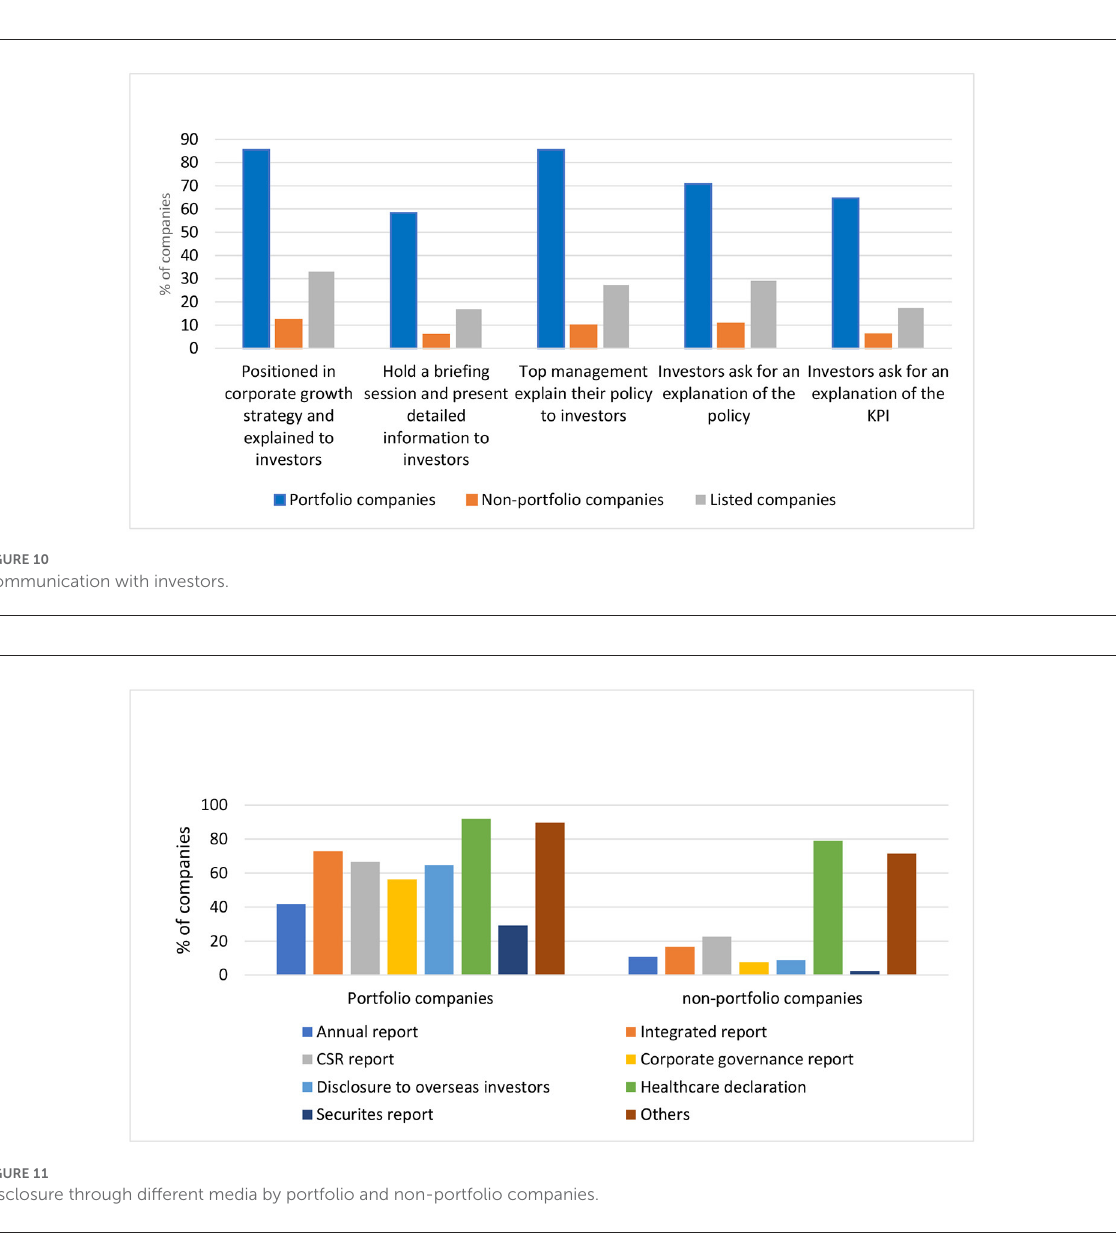
portfolio companies are more desired by investors and are responding to this